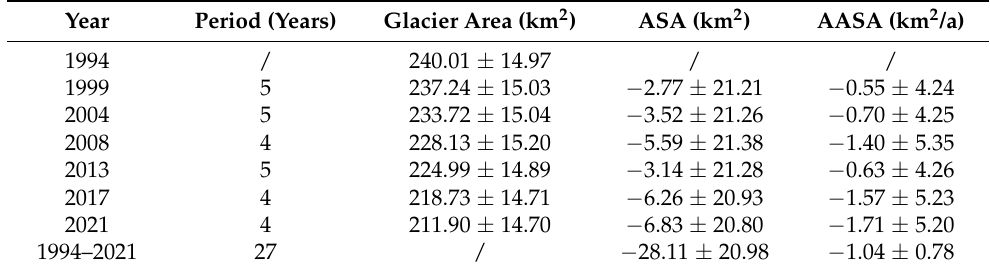
Table 5. Statistics of glacier area changes.